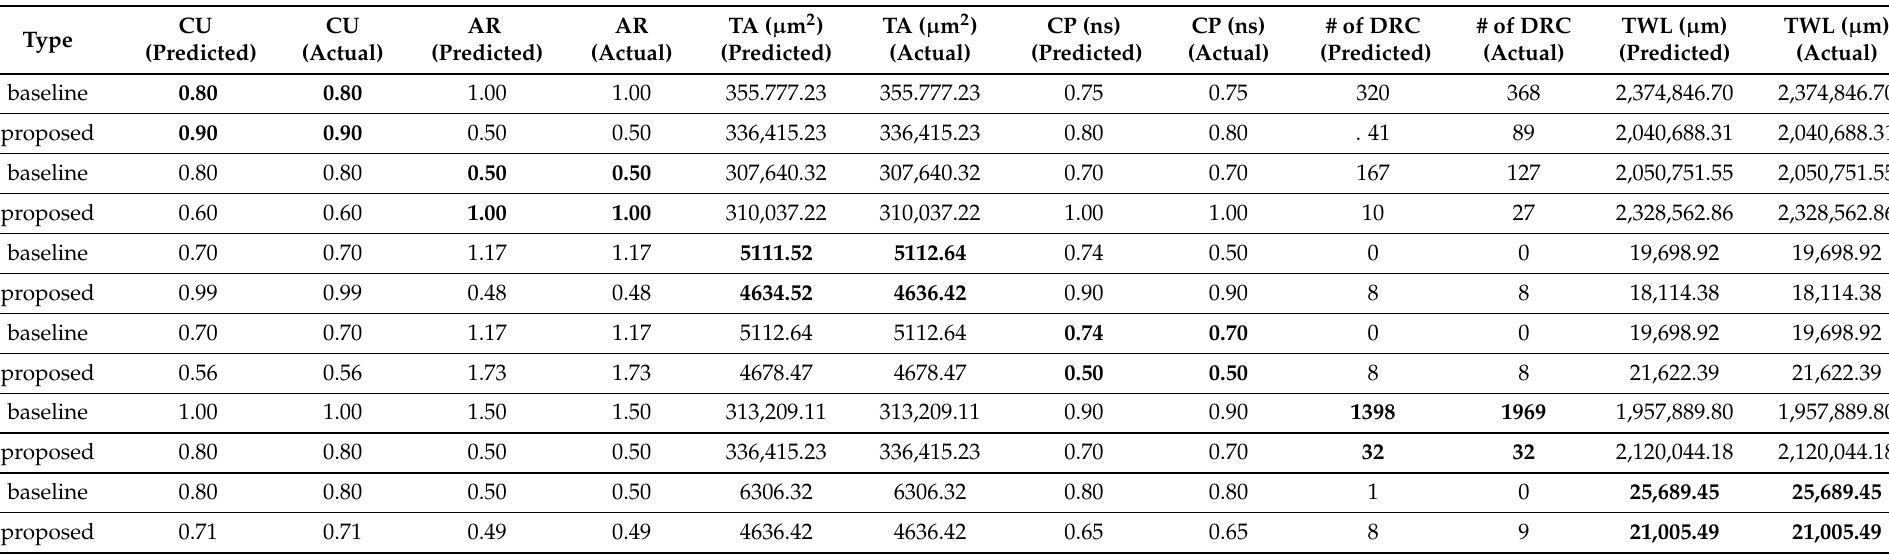
Table 1. For the 589 input designs, using the proposed technique and suggested design constraint, a designer can reduce up to 87% DRC violations with only a 2.6% extra